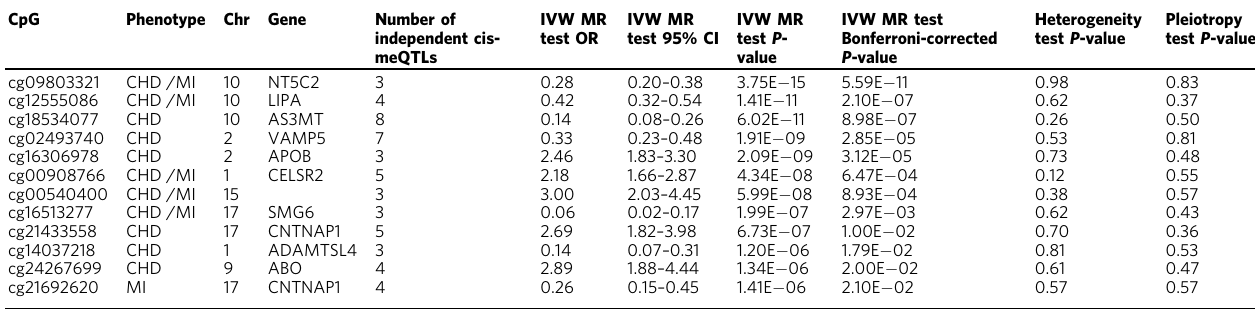
Table 1 Mendelian randomization results of coronary heart disease and myocardial infarction